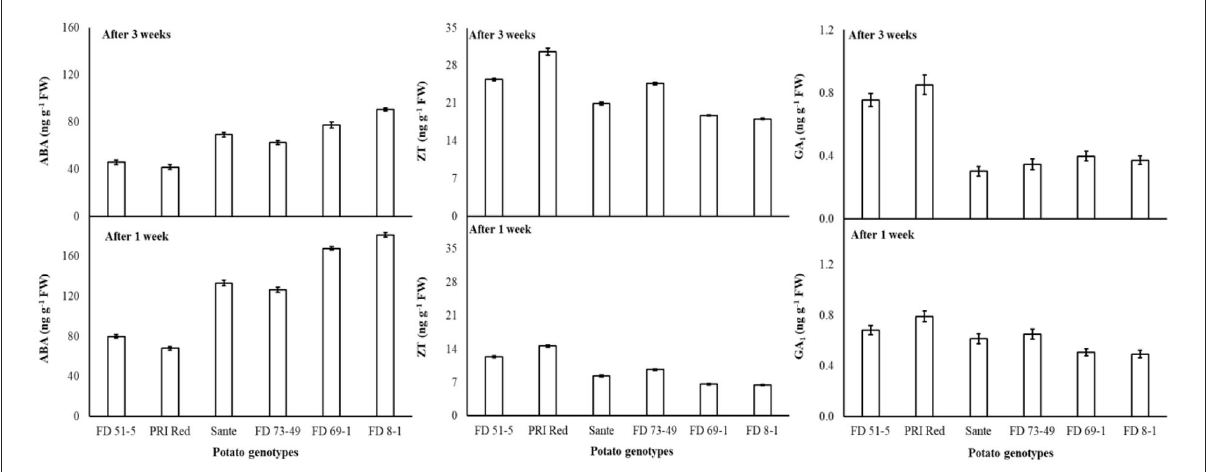
FIGURE6 Change in ABA, ZT, and GA 1 levels in tuber during storage period (3 weeks) following treatment with electric current. Vertical error bars represent standard error of means (n: 4).